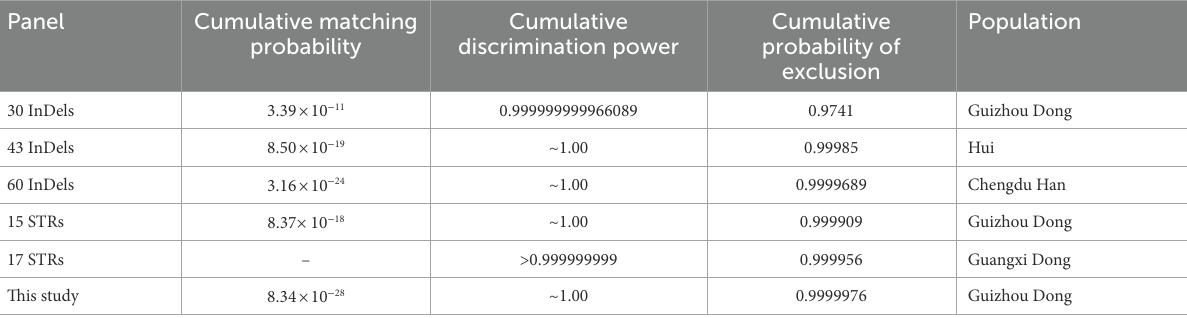
TABLE 1 Forensic efficiency comparisons of different